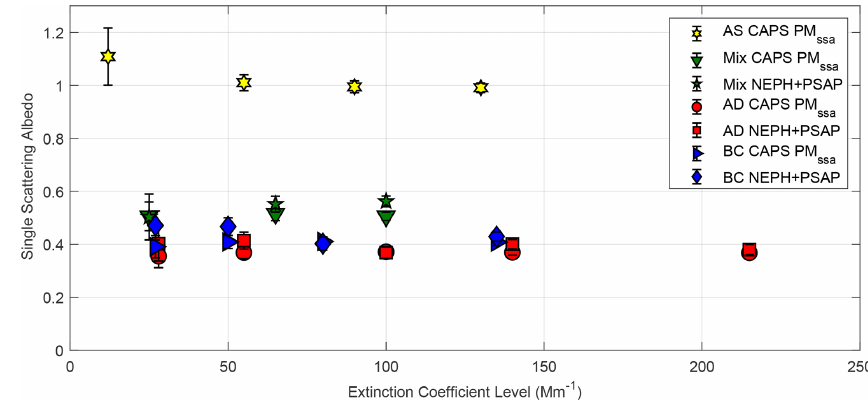
Figure 12. Average and standard deviation of the measured single-scattering albedo as a function of extinction coefficient level for the different aerosols and technologies.